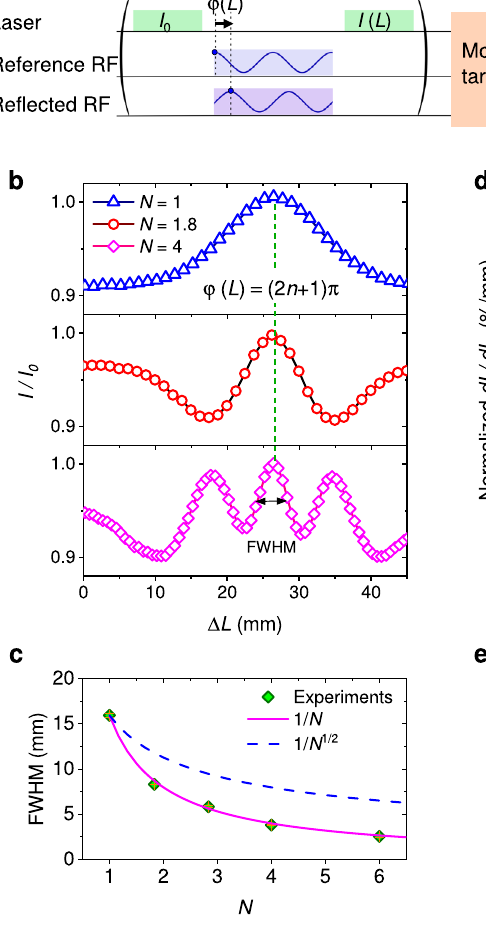
Fig. 3 | The high accuracy radio ranging with quantum sensor. a The pulse sequence for RF ranging. Fluorescence signals of NV center ensemble before and aftertheRF-spininteractionarerecordedasareference I 0 andarangingsignal I ( L ). b The normalized ranging signalisplotted asthe function oftarget ’ s position. The number N ismodi fi ed bychanging the RFpulse duration here.The smallest FWHM isobtainedatthepositionwhere φ ( L )= π ( B RF =0). c FWHMoftherangingsignalis reduced as 1 N . The green squares are experimental results, while solid and dashed